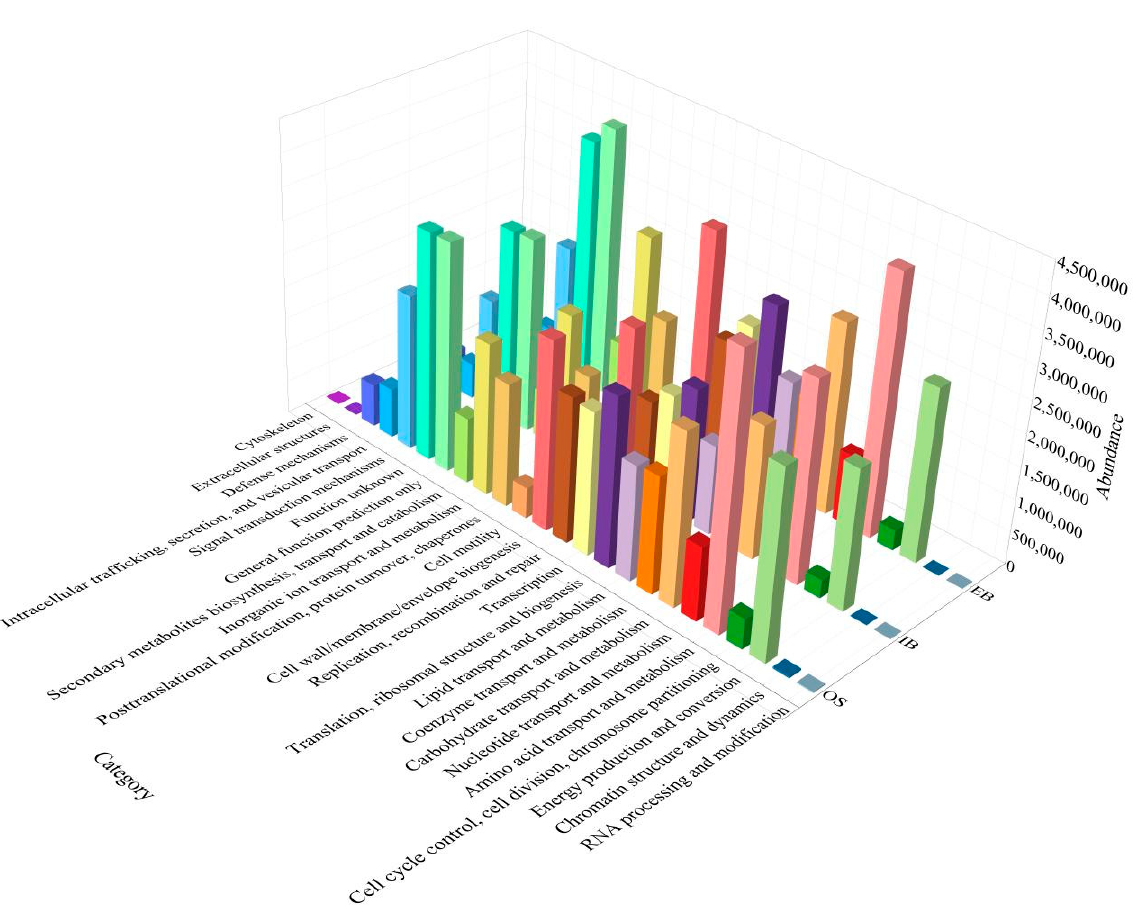
Figure 7. COG functional classification statistics for the immobilized petroleum–degrading bacteria beads in different areas (original seawater (OS); water inlet site (IB); water outlet site (EB)).